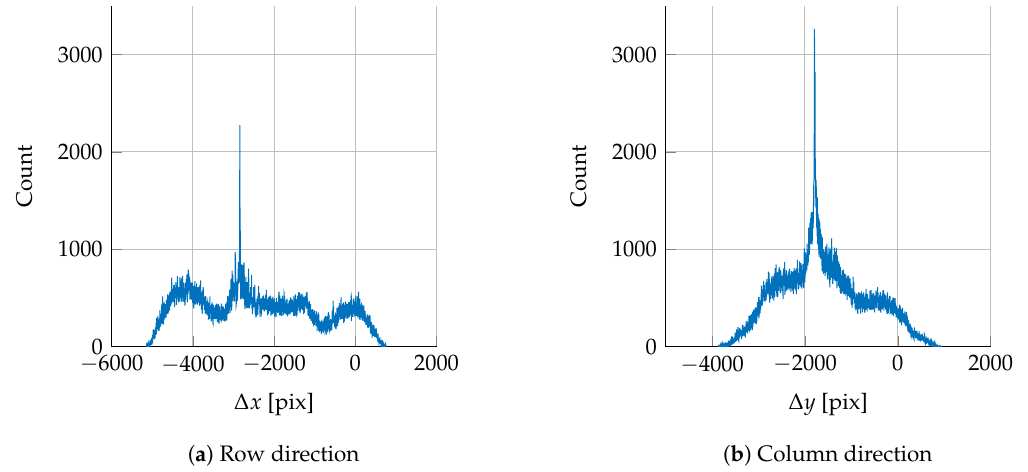
Figure 7. Geometric match verification of the Container scenario with histogram voting. Distribution of pixel distances for all putative matches according to the one-to-many matching in the ( a ) row and ( b ) column direction. Distinct peaks represent unknown